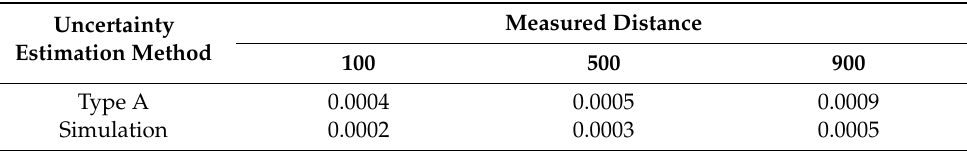
Table 3. The uncertainties obtained with simulation and on the basis of ball-bar measurements. All values given in